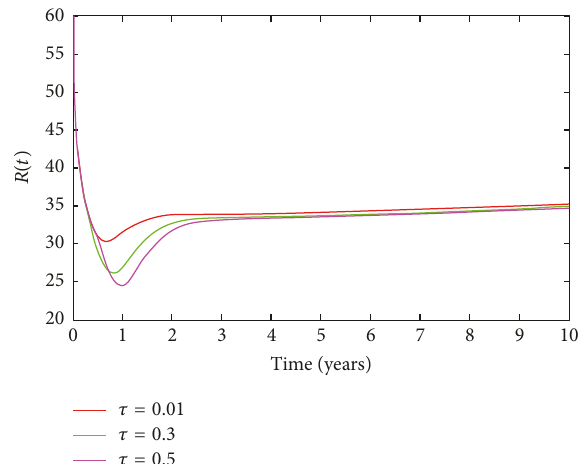
Figure 9: The approximate solutions with different 𝜏 and 𝛼 = 0.9 using NSFDM.